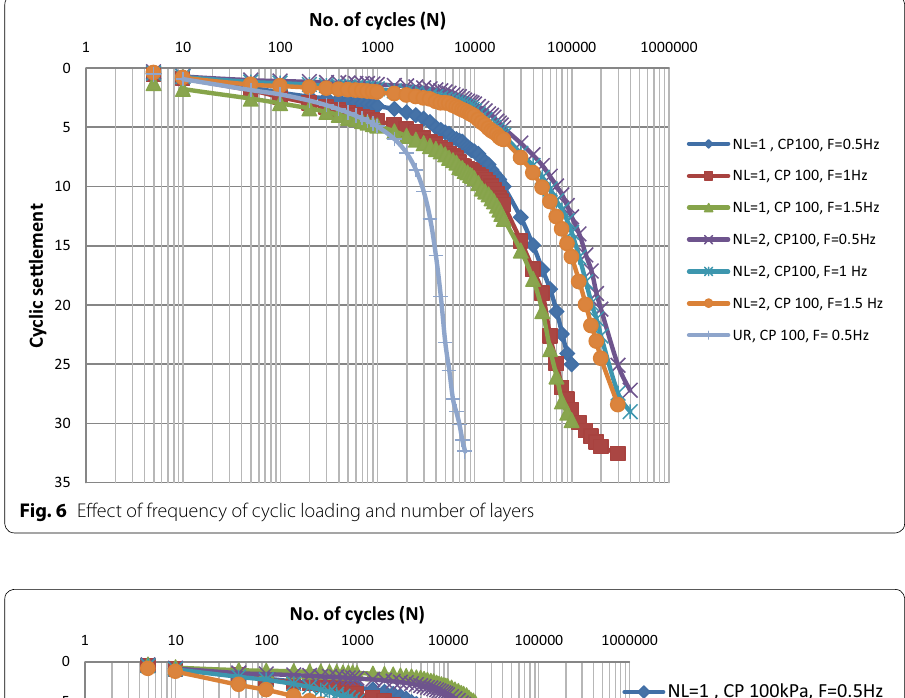
Fig. 6 Effect of frequency of cyclic loading and number of layers